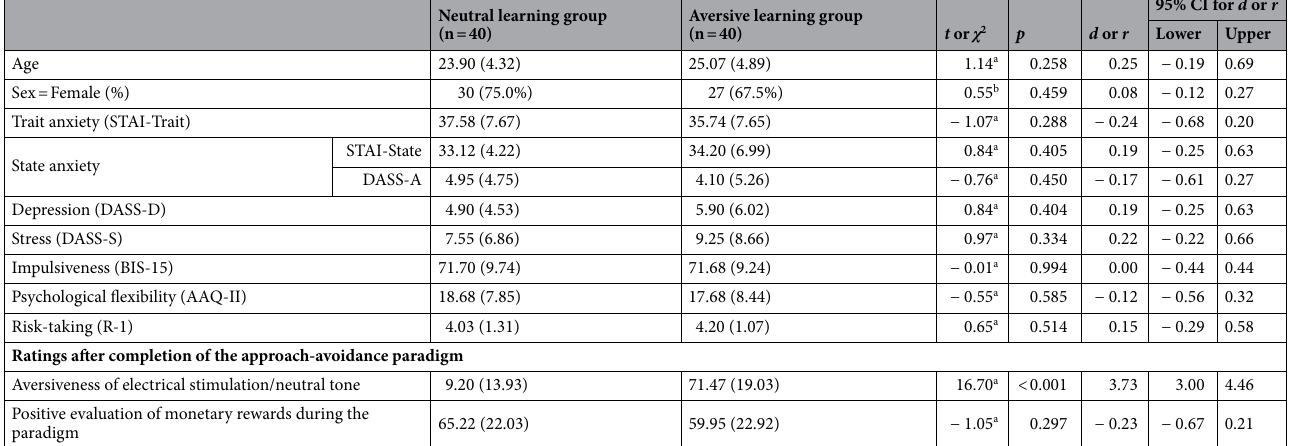
Table 1. Means (and standard deviations) for socio-demographic and questionnaire data. STAI State-Trait Anxiety Inventory 29 , DASS Depression Anxiety Stress Scales 31 , BIS-15 Barratt Impulsiveness Scale 32 ,